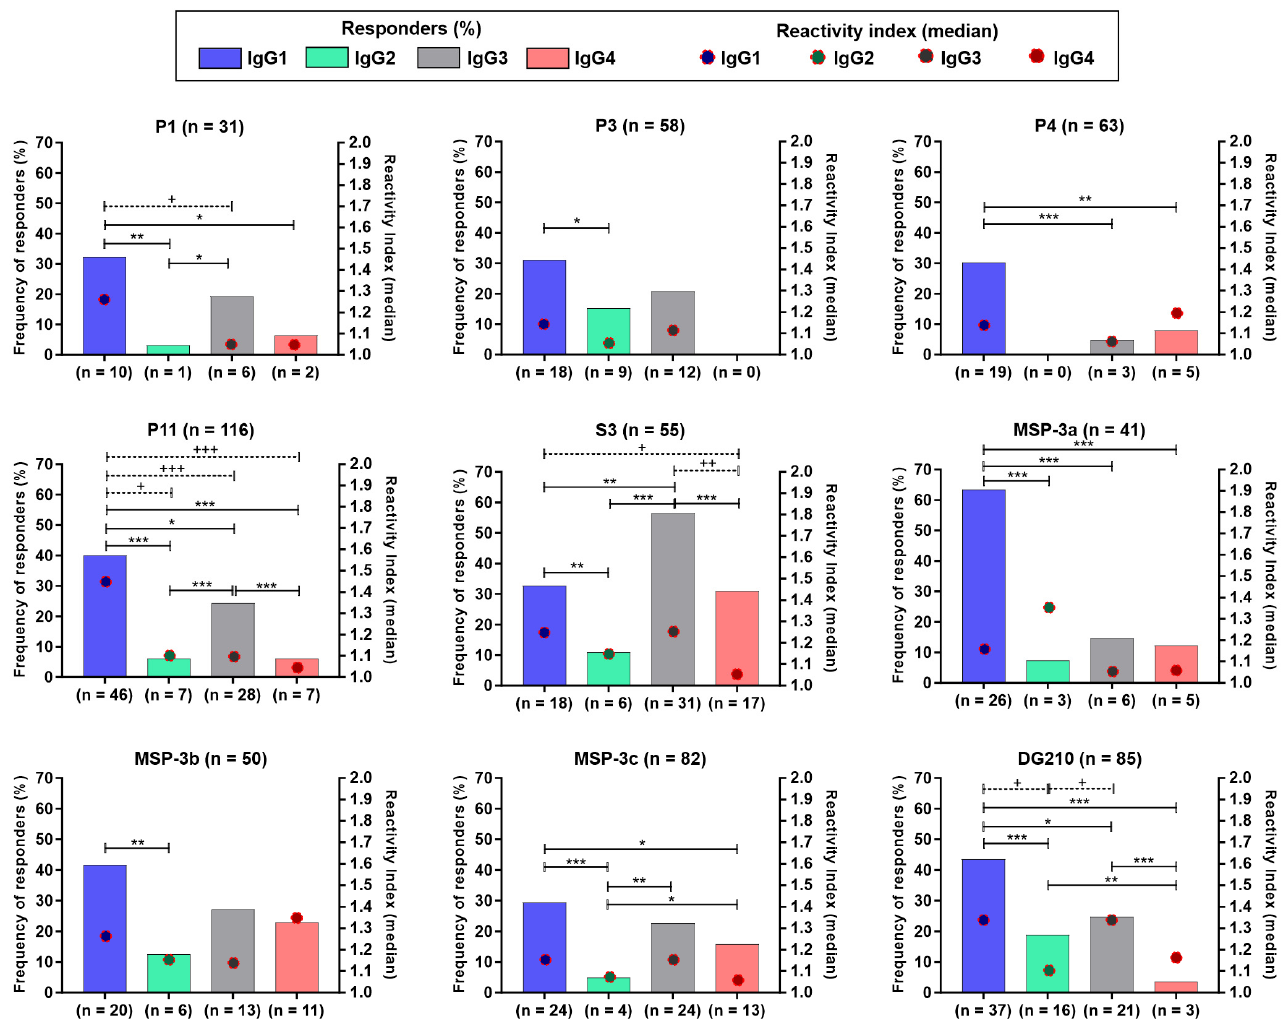
Figure 4. Frequency and levels of IgG subclasses against the immunodominant epitopes from GLURP 27–500 and MSP-3 155–249 . The bars represent the frequency of responders, and the circles with broken red lines represent IgG subclasses levels (median). Significant differences among subclass frequencies were indicated by * and significant differences among subclasses levels were indicated by +; (*; +) p < 0.05; (**; ++) p < 0.005; (***; +++) p < 0.0005. IgG1 antibody levels against P1 and P11 were positively correlated with age and time of residence in malaria-endemic area (P1: p = 0.002; r = 0.530; for both; P11: p = 0.02; r = 0.207; p = 0.03; r = 0.201; respectively). In addition, IgG3 antibody levels against DG210 were associated with the number of previous malaria episodes ( p = 0.034; r = 0.240), while IgG1 antibody levels against P3 were negatively correlated with time elapsed since the last malaria episode ( p = 0.024; r = − 0.316).